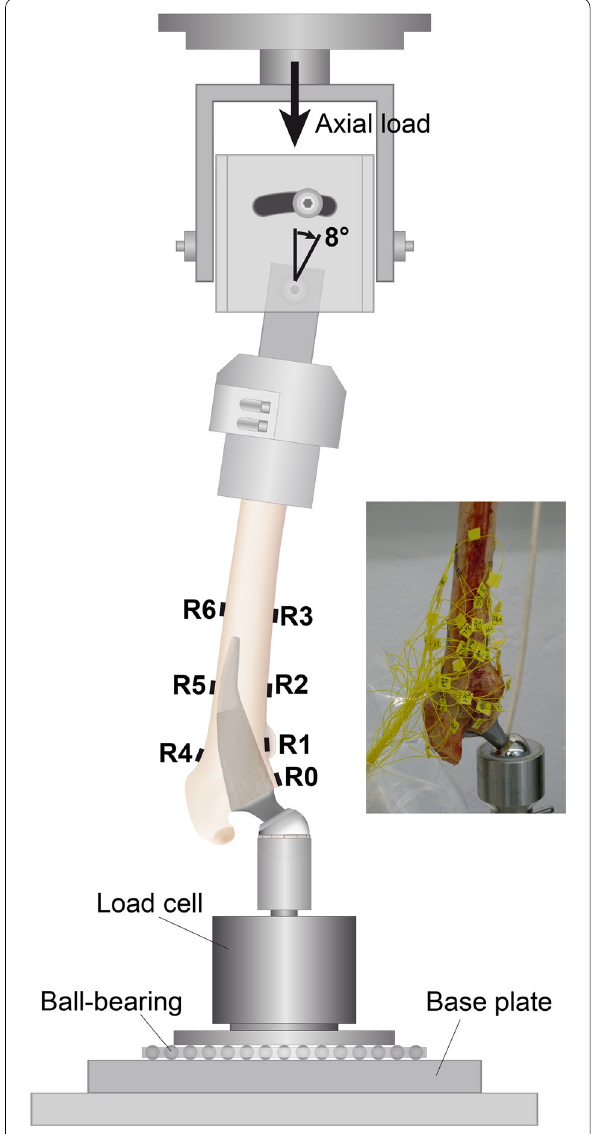
Fig. 4 Illustration of the cortical strain measurement set-up. R0 to R6 show the positions of the strain gauge rosettes. R1 was attached medially at the level of the lesser trochanter and R4 laterally below the greater trochanter. The level of the middle section (R2 & R5) was 40 mm proximal and the distal rosettes (R3 & R6) were bonded 20 mm distal to the tip of the implant. R0 was attached medially 4 mm below the calcar